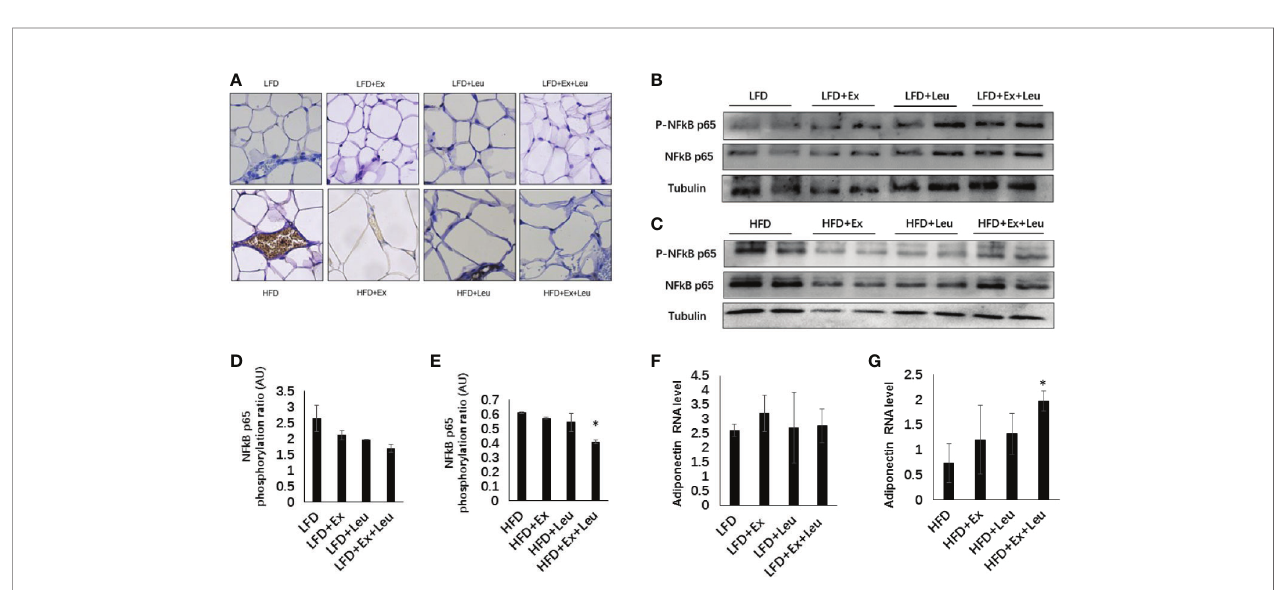
FIGURE 4 | Intervention of exercise and leucine enhanced adiponectin secretion and reduced adipose tissue in fl ammation under HFD. C57BL/6J male mice of 5 – 6 weeks were fed with LFD or HFD. Leucine with a concentration of 1.5% and/or moderate intensity exercise was added in the 10th week and administrated for 4 weeks. (A) Adipose tissue immunohistochemistry. The sections of adipose tissue were immunostained for F4/80. For (B, C) , the levels and phosphorylation states of NF- k B p65 were determined using western blots. For (D, E) , quanti fi cation of in fl ammatory signaling (arbitrary units) for (B, C ), respectively. For (F, G) , changes in adipose mRNA level of adiponectin by RT-PCR under LFD and HFD, respectively. The data are mean ± s.d. (error bars), n = 6 mice per group. *p < 0.05, HFD versus HFD + Ex + Leu.